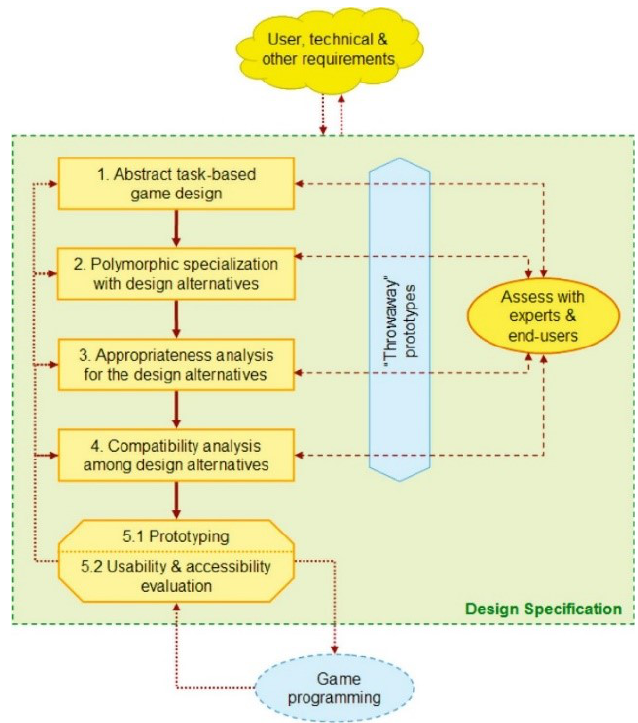
Fig. 1. Steps of Unified Design for universally accessible games. (From